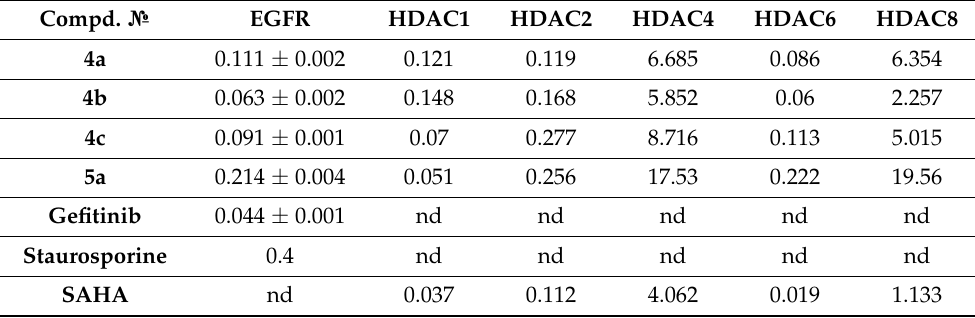
Table 2. Effects of hybrids 4a – c , 5a , Gefitinib , staurosporine and SAHA on EGFR and HDAC1, 2, 4, 6 and 8 (IC 50 µ